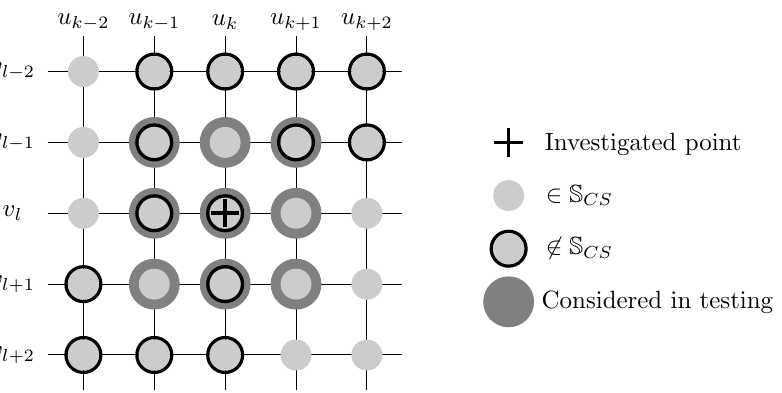
Figure 5. Schematic sketch of the domain that is considered in the outlier detection. The domain is predefined by the neighbourhood [ u k